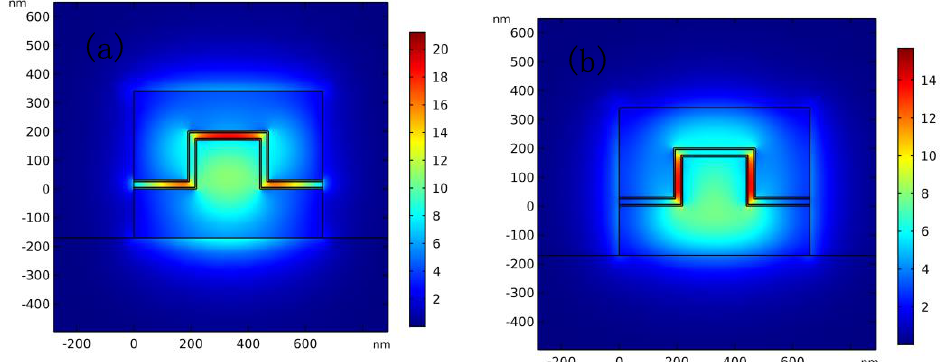
Figure 3. The mode field distribution in the waveguide. ( a ) The TM mode field distribution ( b )